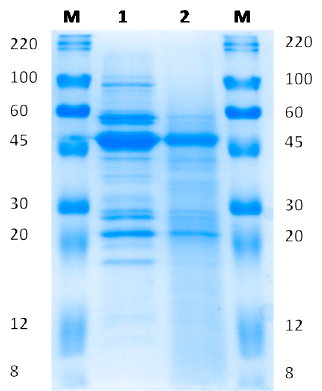
Figure 1. Detection processes of V. radiata protein digestion by germination process.Band pattern in SDS-PAGE. M , molecular weight markers; 1 , raw V. radiata protein extract; 2 , 4 day-germinated protein extract. The amount of Kjeldahl-N loaded per lane was 2.0 µg. The figure is representative of 3 independent analyses.